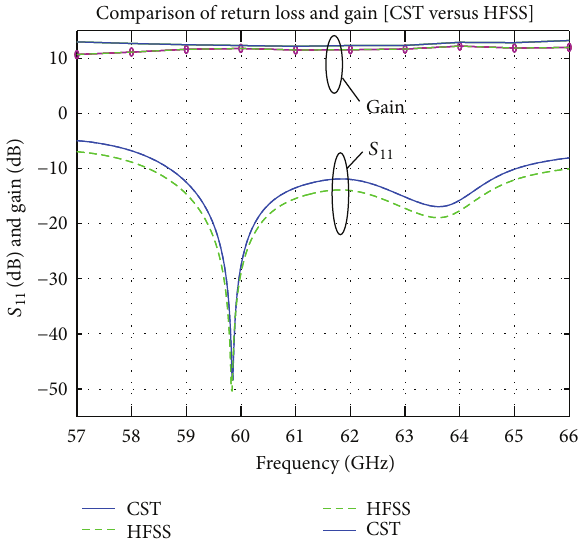
Figure 2: Comparison of return loss and